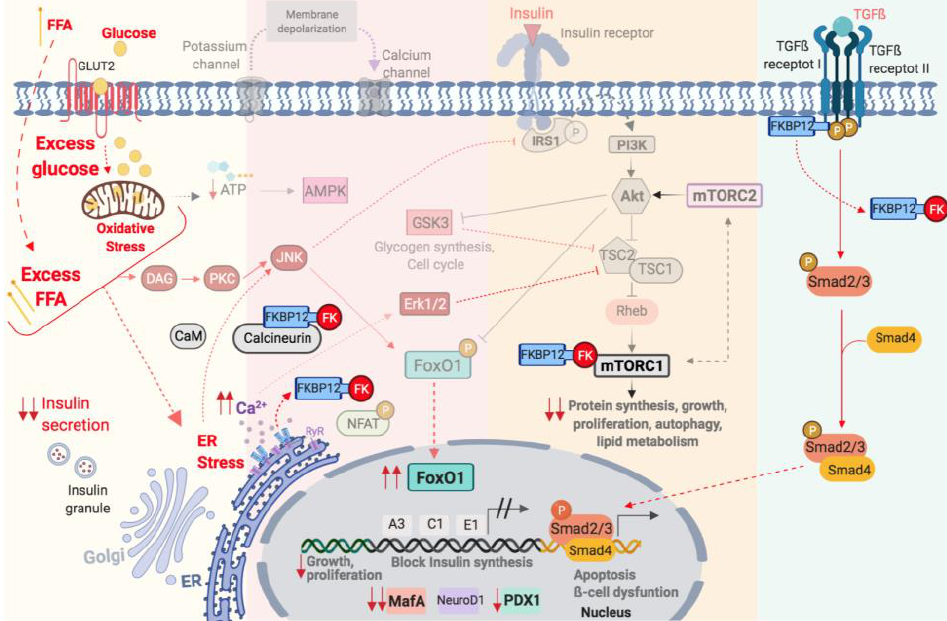
Figure 3. Schematic illustration of the action of Tacrolimus in the context of glucolipotoxicity on pancreatic β–cell.